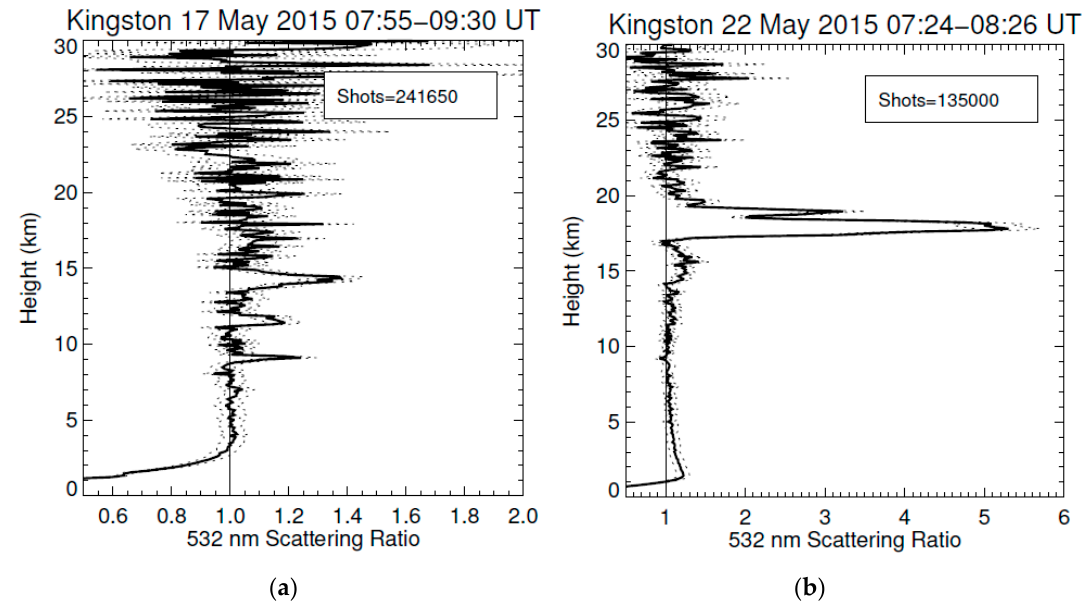
Figure 5. Retrieved 532 nm scattering ratio for Kingston lidar measurements on ( a ) 17 May and ( b ) 22 May 2015 at 100 m vertical resolution. Note the different horizontal scales. The solid vertical line marks unit scattering ratio. Thin dashed lines mark 1 σ significance limits.